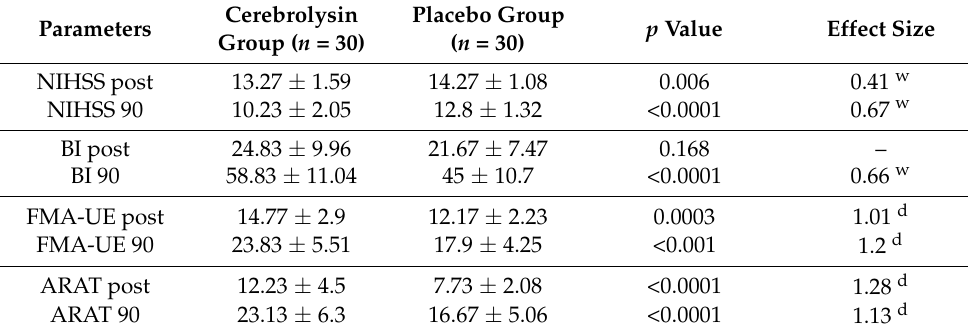
Table 6. The comparisons in outcomes between groups.